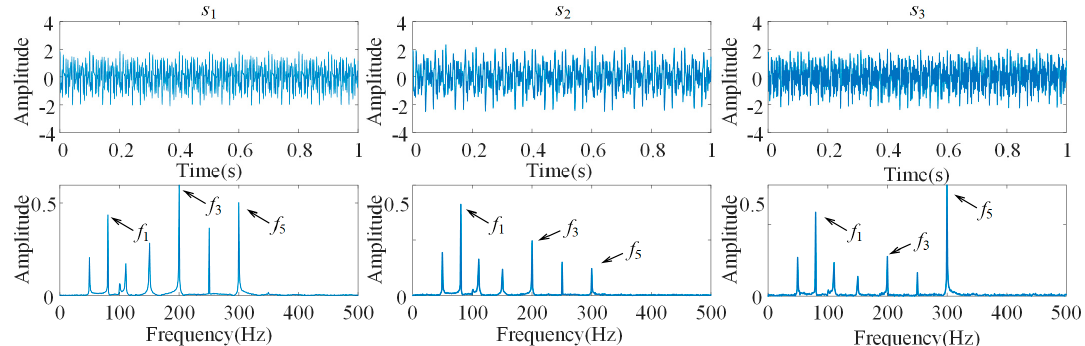
Figure 2. Time domain and frequency domain Figure of simulation signal.